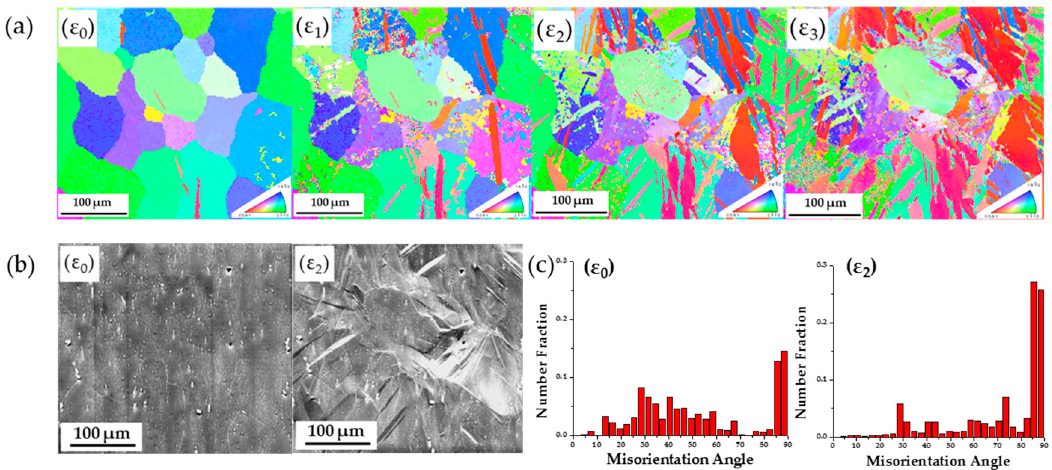
Figure 8. ( a ) Texture evolution and twin activity monitoring of the ND specimen at corresponding strain values marked in the stress-strain curve of Figure 7; ( b ) SEM images at corresponding strain values ε 0 and ε 2 ; ( c ) misorientation angle distribution between 0 and 90 degrees at corresponding strain values ε 0 and ε 2 .